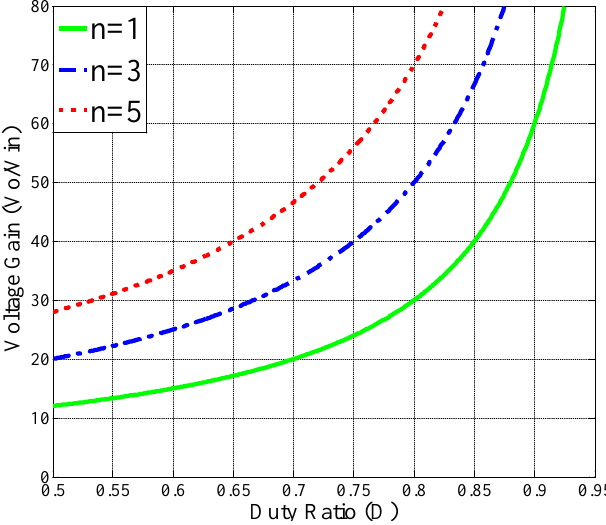
Figure 5. Voltage gain of the proposed converter verse duty ratio for several turns ratio n .